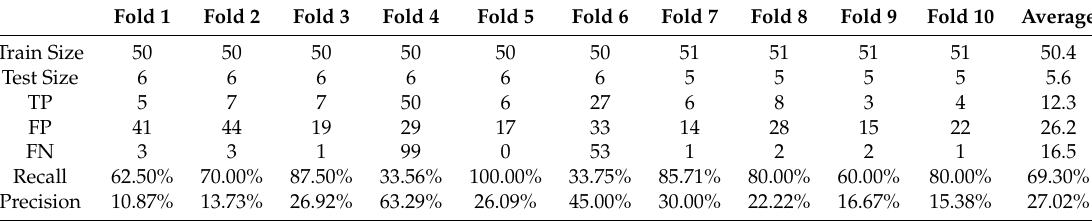
Table A5. The Results of Experiment 5: Augment 50% of dataset containing images with and without dents (Dataset